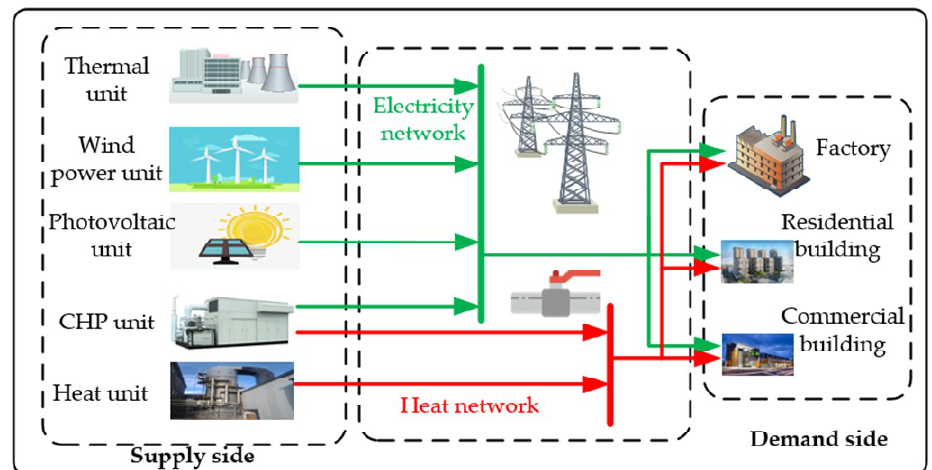
Figure 1. Optimal energy dispatch (OED) framework of combined heat and power-thermal-wind-photovoltaic systems.